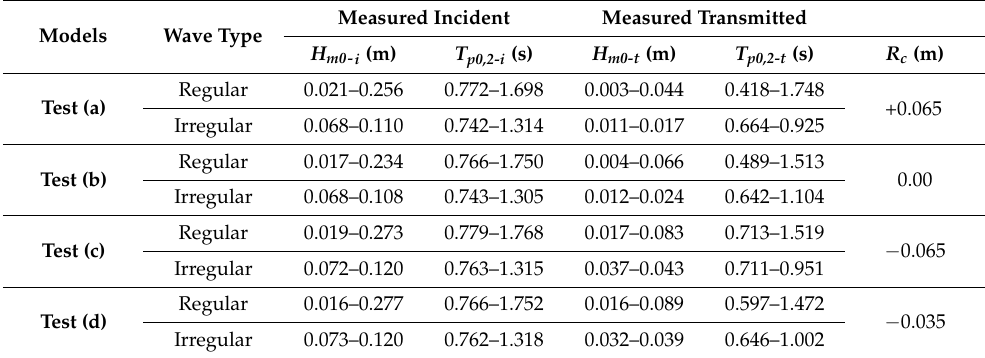
Figure 3. Rubble-mound breakwater configurations tested in the present study. Test ( a ): emerged breakwater ( R c = 0.065 m); Test ( b ): zero-freeboard breakwater ( R c = 0); Test ( c ): submerged breakwater ( R c = − 0.065 m); and Test ( d ): submerged breakwater ( R c = 0.035 m). Table 3. Wave parameters measured in the laboratory.